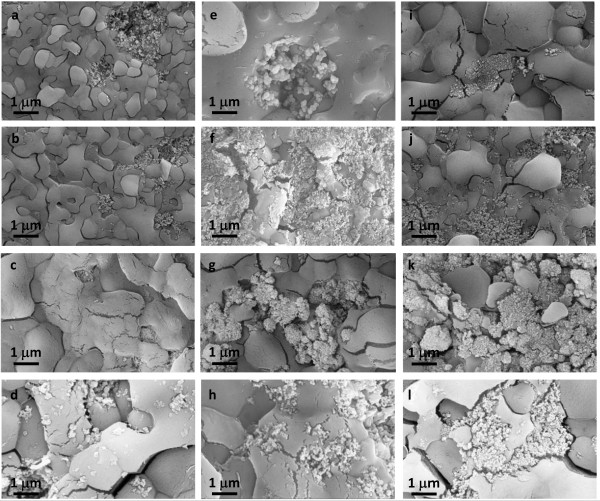
SEM micrographs of nanofluids based on NaNO3-KNO3 with 0.5 wt.% (a,b,c,d), 1.0 wt.% (e,f,g,h), and 1.5 wt% (i,j,k,l) of nanoparticles. silica (a,e,i), alumina (b,f,j), titania (c,g,k) and alumina-silica nanoparticles (d,h,l).